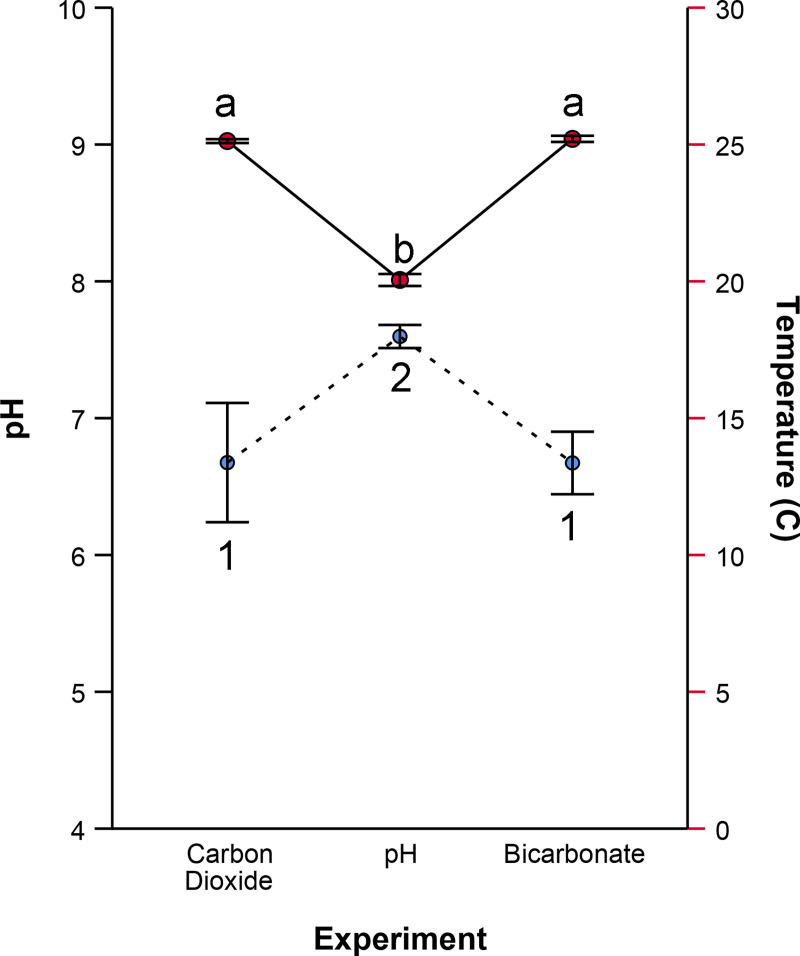
Initial environmental conditions among experiments.Points represent average initial temperature (solid line) and pH (dashed line) for the carbon dioxide (n = 16), pH (n = 24), and bicarbonate experiments (n = 16). Error bars indicate 95% confidence intervals. Points labeled with similar letters were compared statistically and those bearing unique numbers differed statistically in pairwise, post hoc comparisons (Tukey p < 0.05 for all significant comparisons).